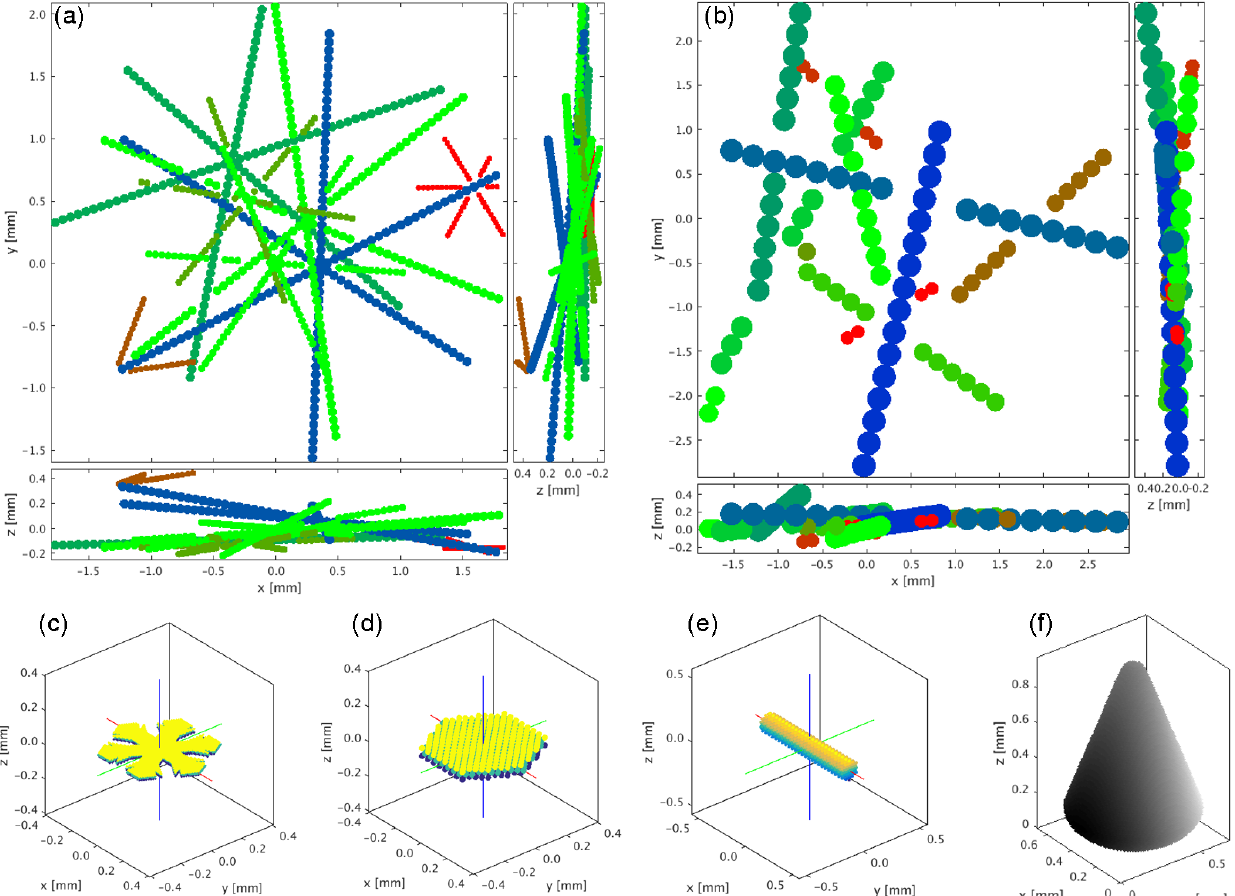
Figure 2. Examples of (a) an aggregate composed of stellar (color-coded) monomers, (b) an aggregate composed of column (color-coded) monomers, (c) a branched planar crystal, (d) a plate, (e) a column, and (f) a conical graupel particle. In panels (a) – (e) the representations are for GMM calculations, and the tiny spheres composing the representations are discernible. The conical graupel particle in (f) is represented as a field of indiscernible polarizable points on a rectangular lattice. Colors are used in (c) – (e) to distinguish different layers of the tiny spheres that compose the ice particles. Note that aggregate scattering properties are computed using GMM only, whereas graupel particle scattering properties are computed using DDA only; all other particle scattering properties are computed with both